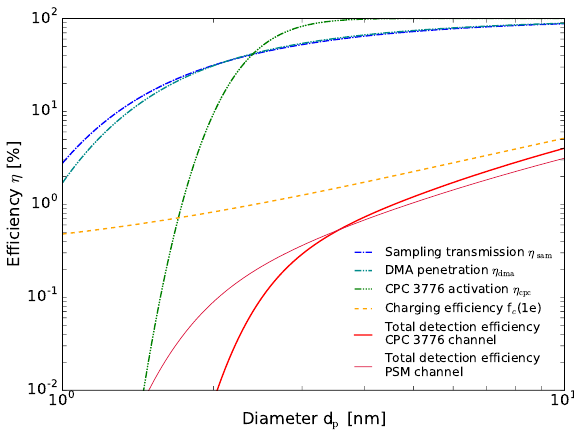
Figure 9. Efficiency in % of the several individual contributions and the total value are plotted against the set diameter at the corre- sponding DMA. This is similar for all three channels using a TSI 3776 CPC as particle counter downstream of the DMA. For the two channels using a Airmodus A10 PSM, the total efficiency is shown as